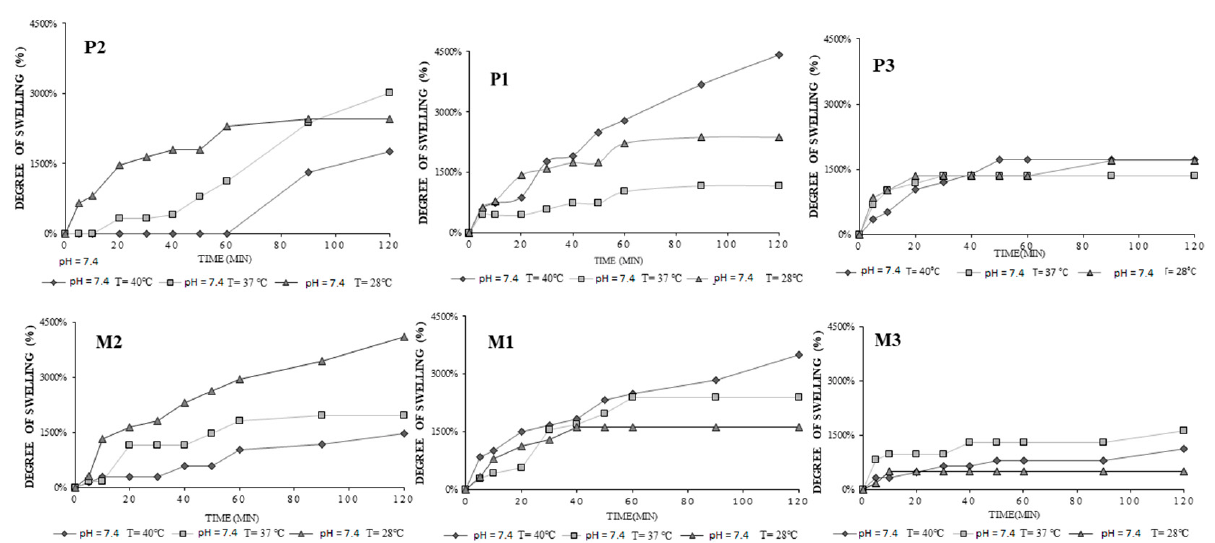
Figure 5. The influence of temperature on the swelling degree, at pH = 7.4. P1: CS-g-PNIPAAm/PVA 80/20 +PGT; M1: CS-g-PNIPAAm/PVA 80/20 ; P2: CS-g-PNIPAAm/PVA 95/5 +PGT; M2: CS-g- PNIPAAm/PVA 95/5 ; P3: CS-g-PNIPAAm/PVA 75/25 +PGT; M3: CS-g-PNIPAAm/PVA 75/25.